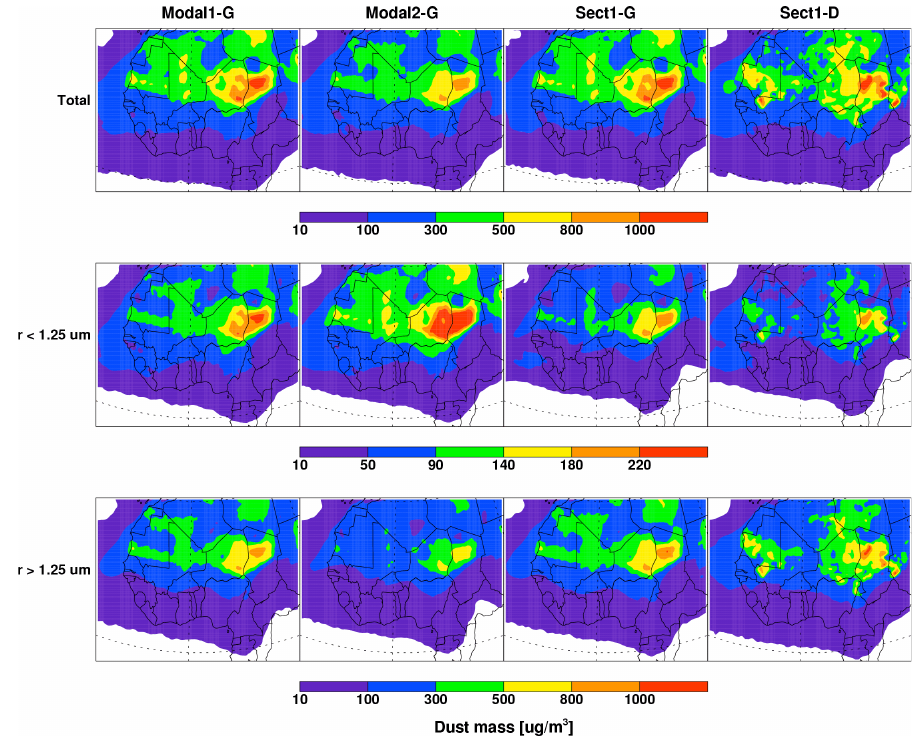
Figure 6 Daytime (9-16 UTC) dust mass concentrations below 1 km AGL for the simulation period over North Africa from the WRF-Chem simulations in four cases: Modal1-G, Modal2-G, Sect1-G, and Sect1-D. The mass concentrations are shown for dust particles in the whole size range (r < 5 µ m), fine dust particles (r < 1.25 µ m), and coarse dust particles (1.25 µ m < r < 5 µ m), respectively.